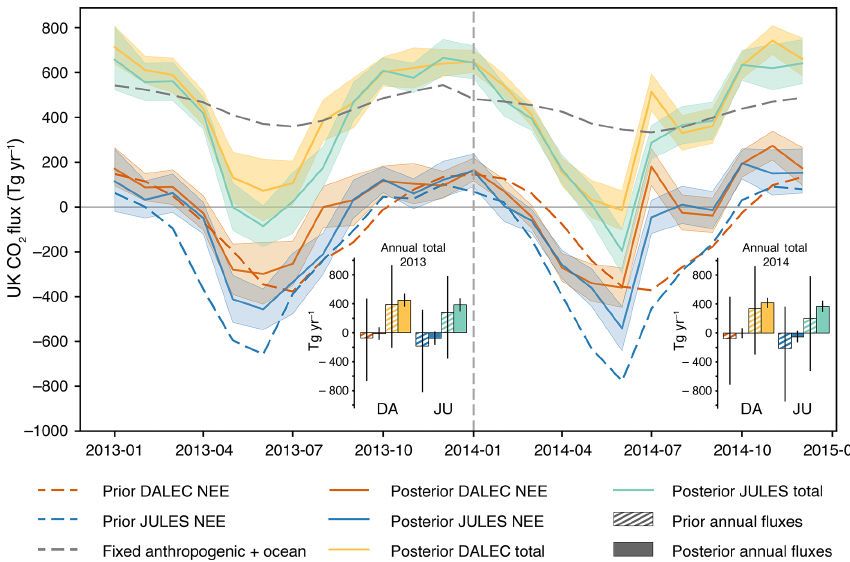
Figure 5. Posterior monthly net UK CO 2 flux (positive is emission to atmosphere). Orange and blue monthly fluxes are posterior net biospheric (NEE) fluxes for DALEC and JULES respectively. Prior biosphere fluxes from DALEC and JULES are shown in dashed orange and blue lines respectively. The fixed anthropogenic and ocean fluxes are denoted by the dark grey dashed line. Yellow and green monthly fluxes are the sum of the posterior NEE fluxes and the fixed anthropogenic and ocean fluxes. Shading represents 5th–95th percentile. The bar charts represent annual net UK CO 2 flux for 2013 (left) and 2014 (right). Hashed bars denote prior annual fluxes; solid bars denote posterior annual fluxes. The bar colours correspond to the line colours: left-hand bars for each model are NEE fluxes; right-hand bars for each model are total fluxes (NEE + fixed sources). Uncertainty bars represent 5th–95th percentile. DA – DALEC. JU –